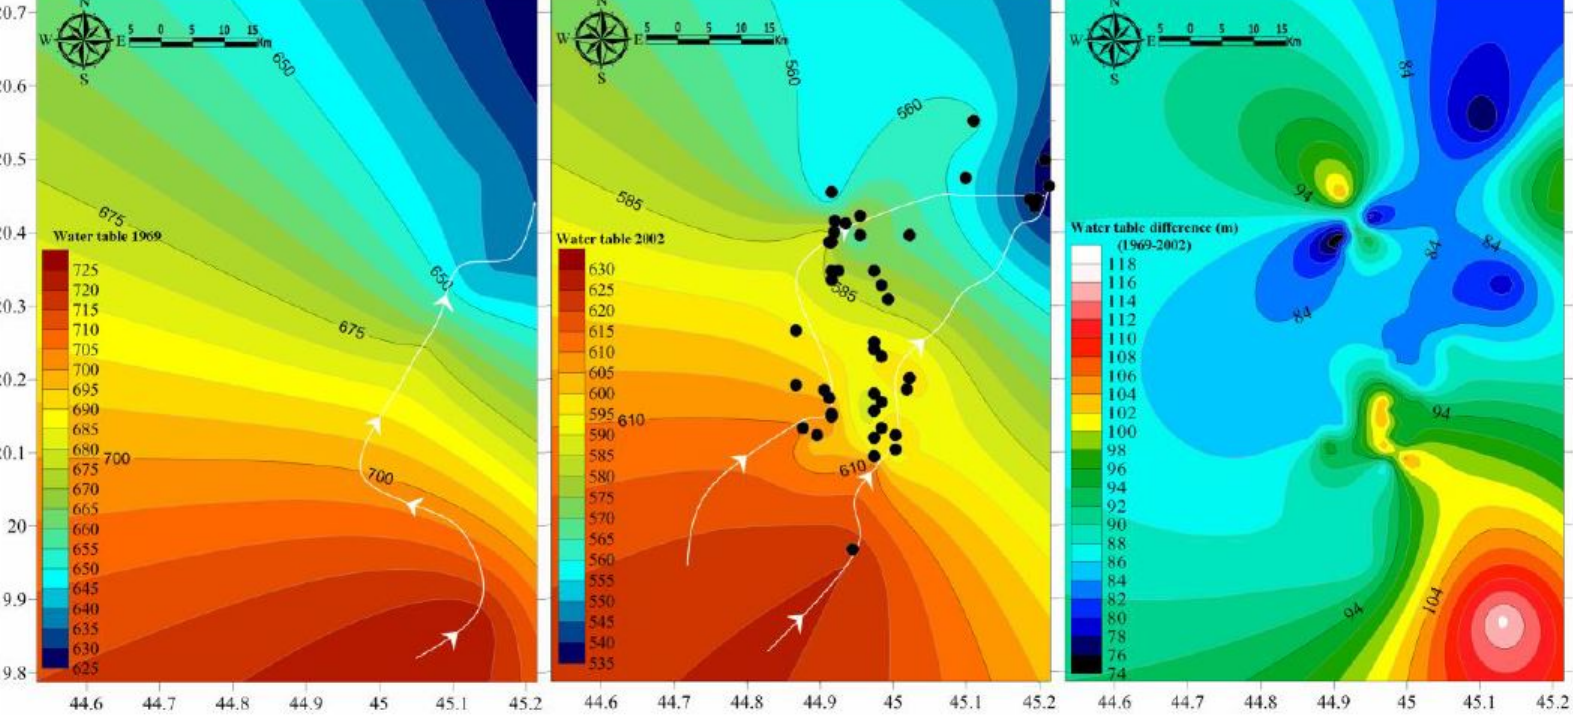
Figure 4. Hydrodynamics showing water table maps of the 1969, 2002, and di ff erence with flow directions and locations of 2002 wells with water table